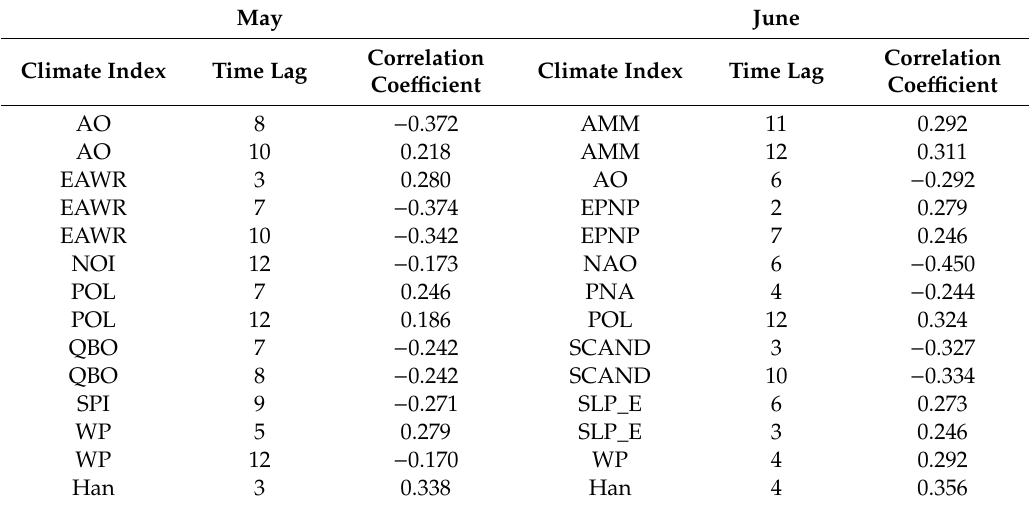
Table 2. Summary of the selected global climate indices, lag time, and correlation coe ffi cients of the May and June